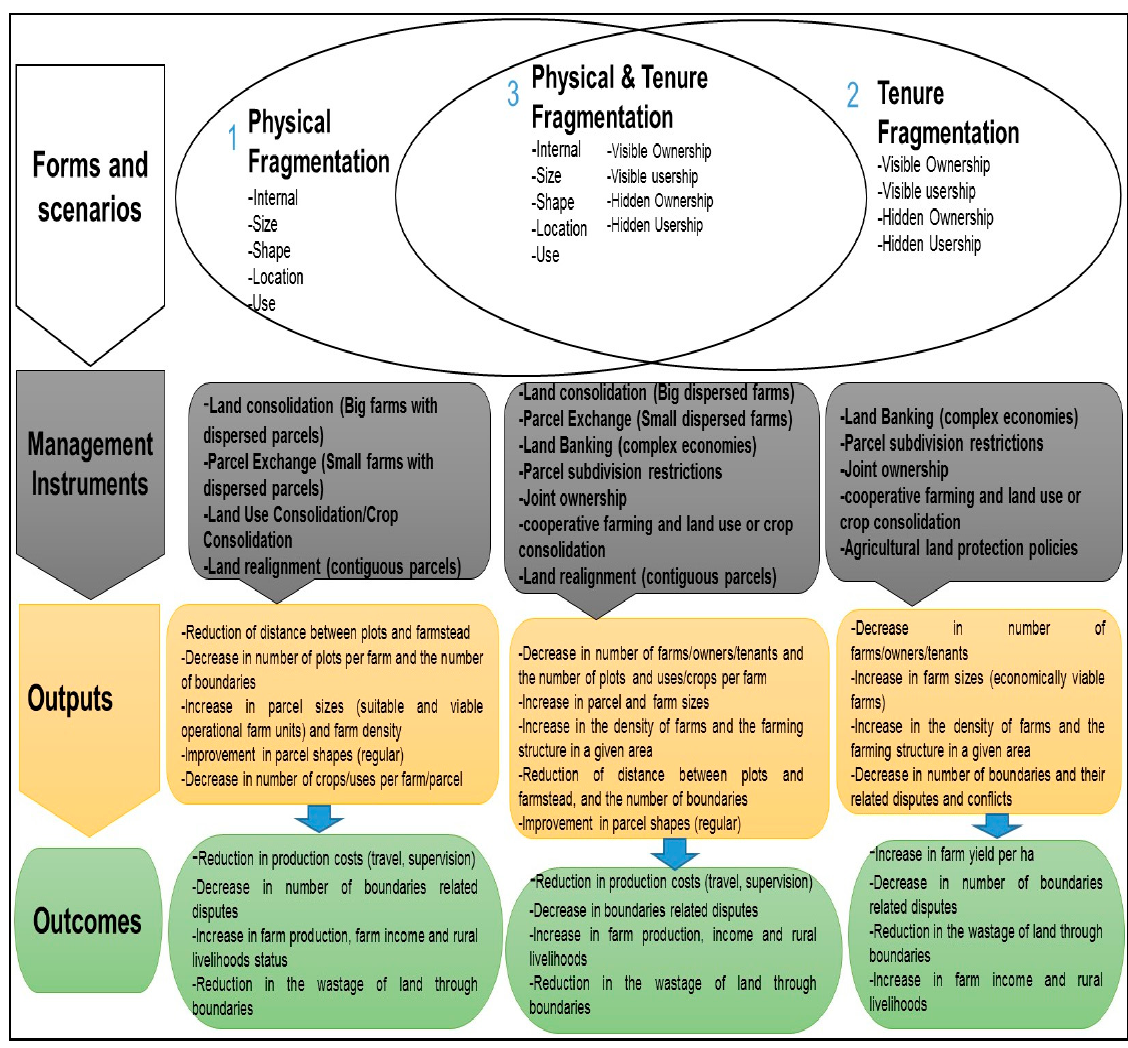
Figure 2. Synthesis of the problematic land fragmentation control strategies (instruments). Source : Developed from the reviewed literature